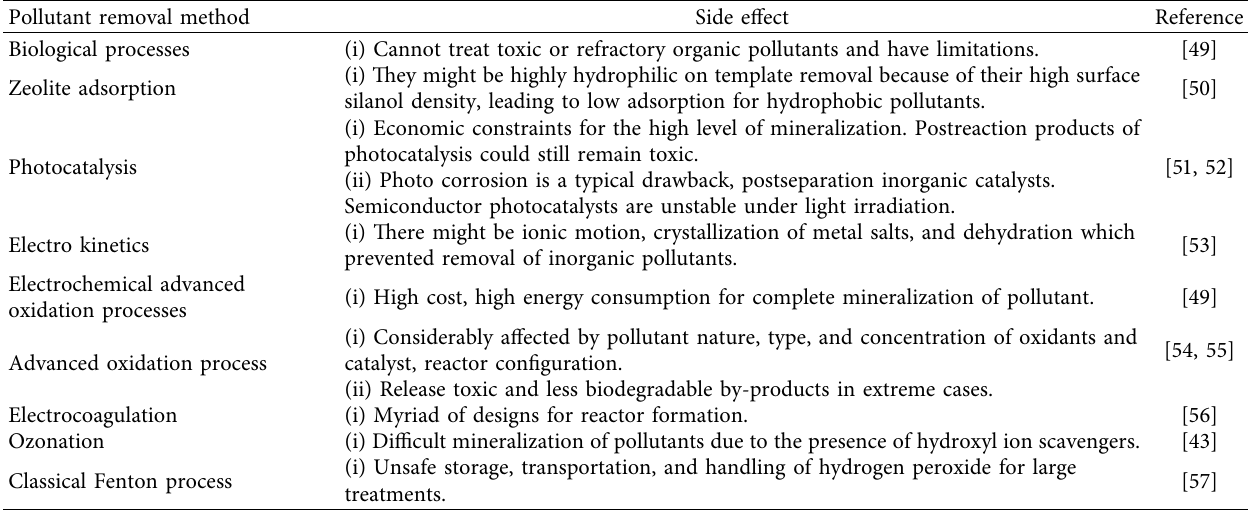
Table 1: Side effects of using traditional processes for pollutant